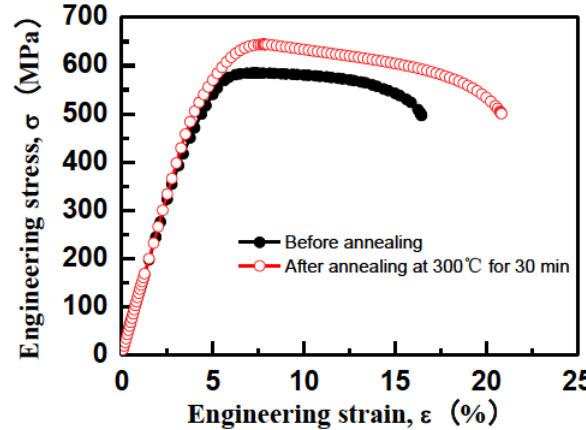
Figure 5: Tensile engineering stress-strain curves of Cu-7%Al alloy berore and after annealing at 300 ∘ C for 30